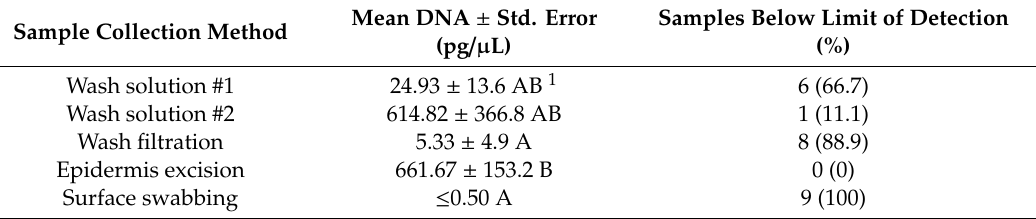
Table 2. Mean DNA recovery from each apple peel microbiome sample collection method.